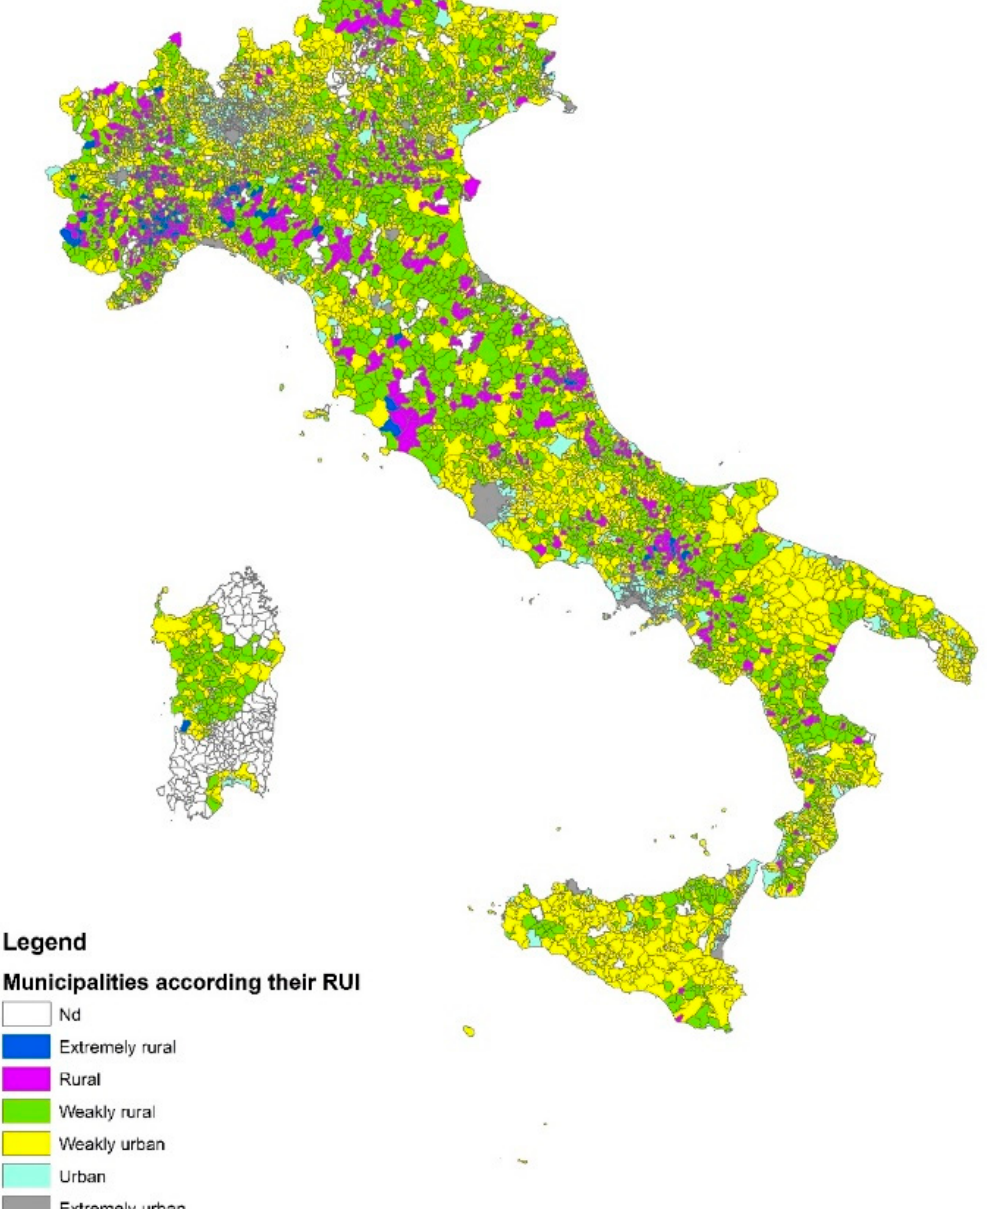
Figure 2. The representation of Italy after applying the Anania and Tenuta method. Territorial classification of each Italian municipality. Source: Anania, Tenuta, 2006.